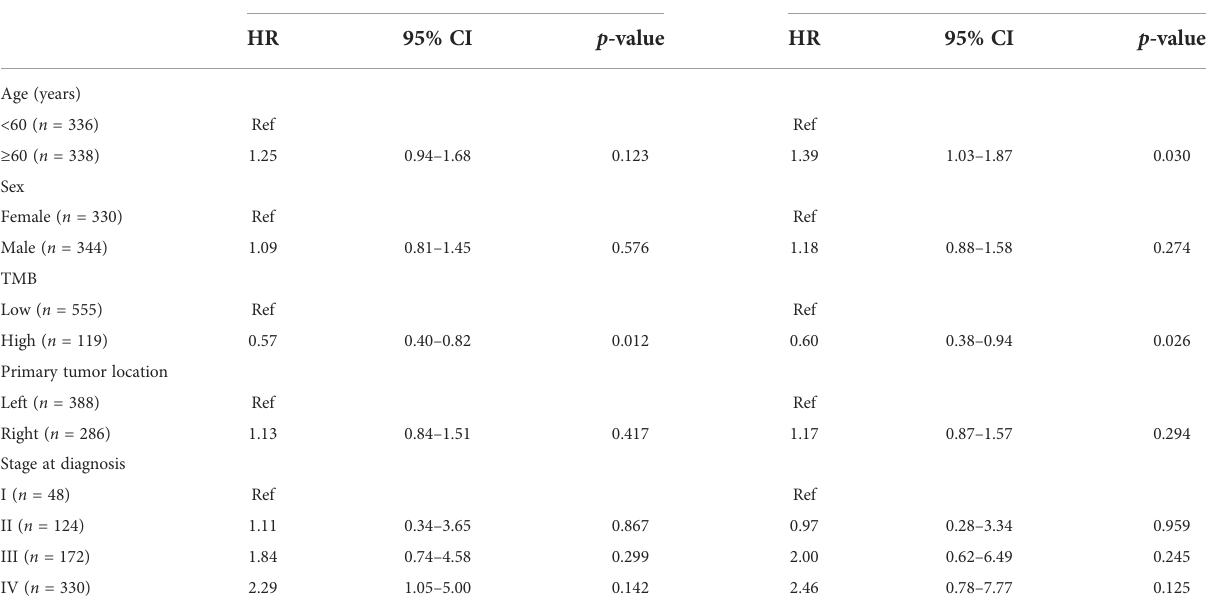
TABLE 4 Univariate and multivariate analyses of overall